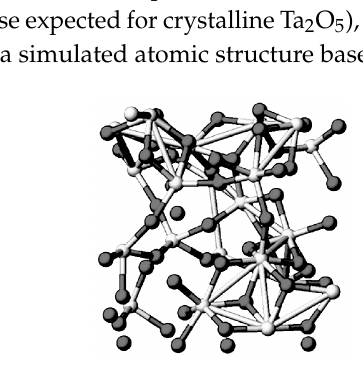
Figure 3. Predicted atomic structure of ion beam ‐ sputtered tantala (dark = O, light = Ta).